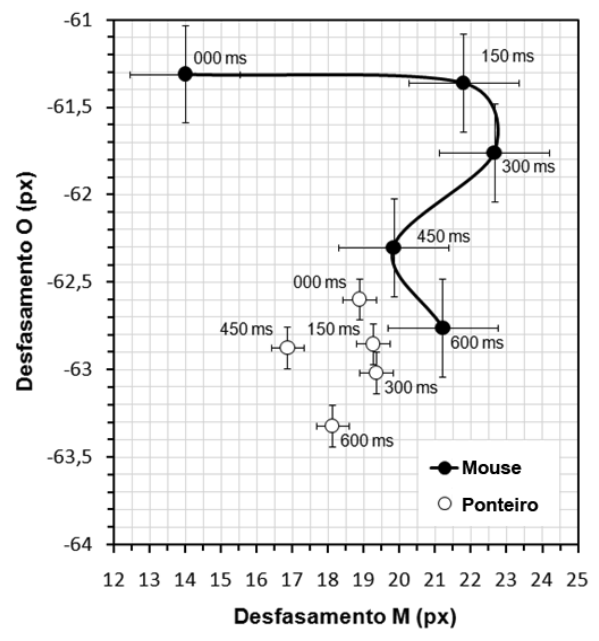
Figura 3 . Mapa dos desfasamentos em pixéis obtidos em função do tempo, tendo como eixo horizontal os valores do componente M e como eixo vertical os valores do componente O. O local de desaparecimento do alvo situa-se na origem (ponto 0, 0). Os círculos indicam as localizações indicadas pelos participantes em função dos tempos de retenção (rótulos). Os círculos negros referem-se à condição Mouse e os círculos brancos à condição Ponteiro. As barras de erro traduzem o erro-padrão da média para ambos os